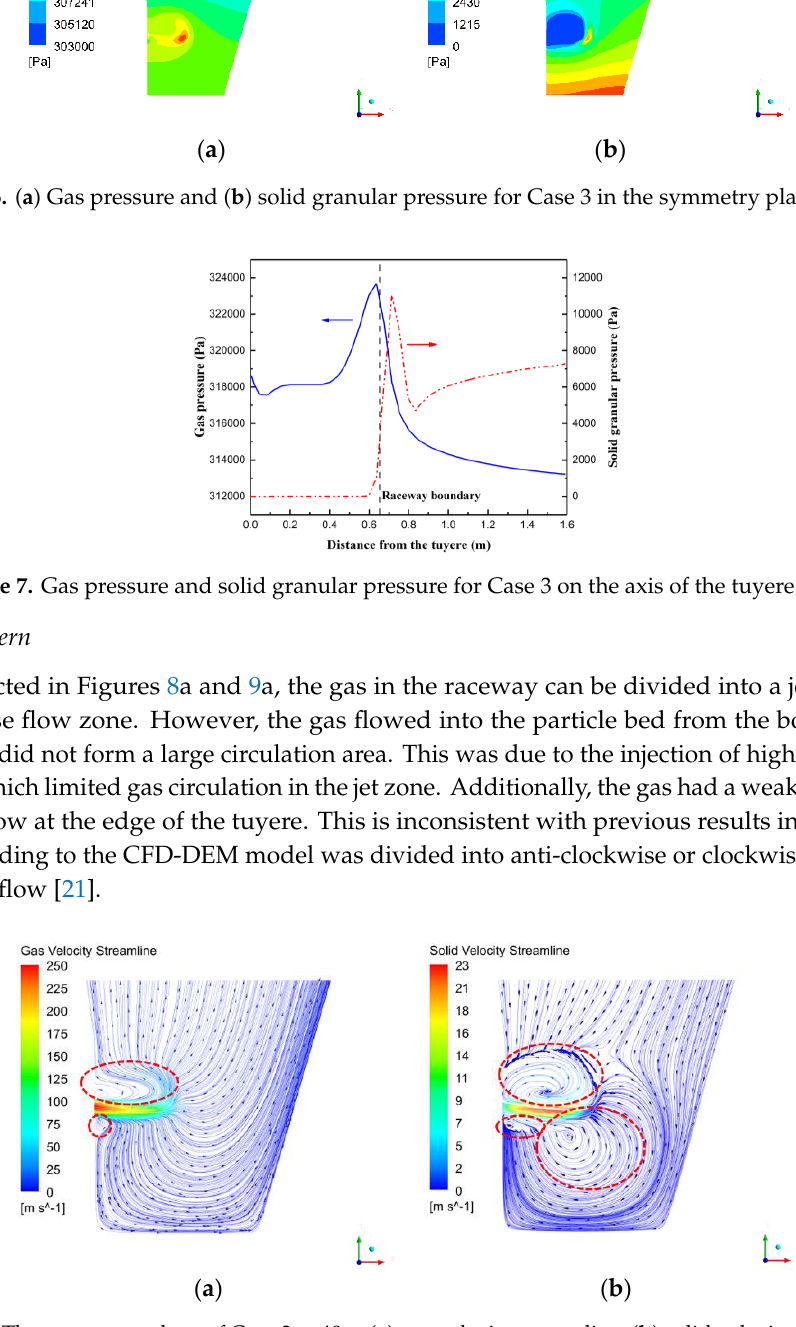
Figure 6. ( a ) Gas pressure and ( b ) solid granular pressure for Case 3 in the symmetry plane at 40 s.